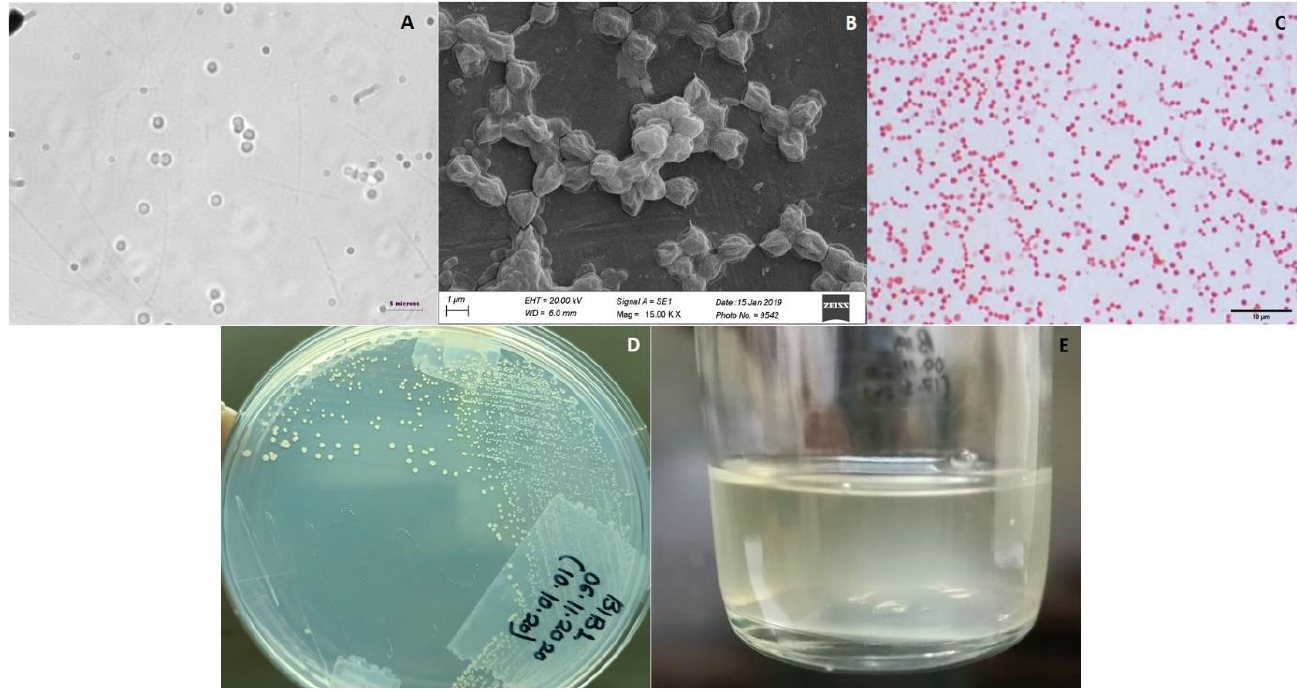
Figure 1. Morphology of strain BlB1: ( A ) live cells were observed under a phase-contrast microscope (Nikon 80i, Japan microscope with a camera) under 100X magnification with oil emulsion; ( B ) fixed and processed culture was observed under Scanning Electron Microscopy (SEM) (Zeiss model EVO-MA-15 SEM); ( C ) Gram-staining under light microscopy; ( D ) colony morphology on solid NMS medium plate; ( E ) BlB1 forms a turbid suspension with a yellow tinge in liquid dilute NMS medium.